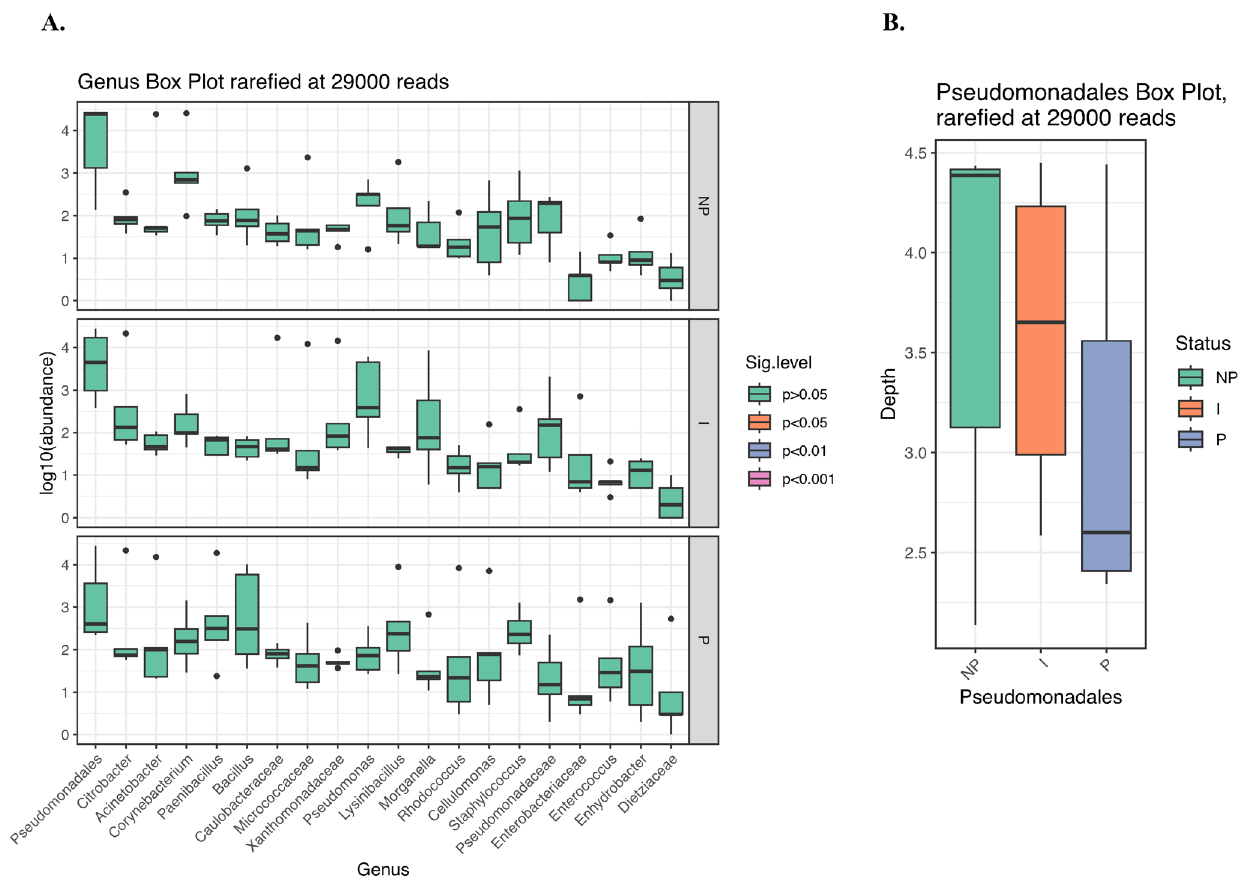
Figure 3. Boxplots representing relative abundance analysis of the bacterial taxa identified in nasal samples of individual from the different S. aureus carrier groups. ( A ) Differential abundance at the genus level. ( B ) Differential abundance for the order Pseudomonadales . Taxa with minimum median abundance of 1% were used for the comparison. There was non-significant difference in abundance among the three carrier groups ( p>0.05, Kruskal–Wallis test ). NP: non-carrier, I: Intermittent, P: